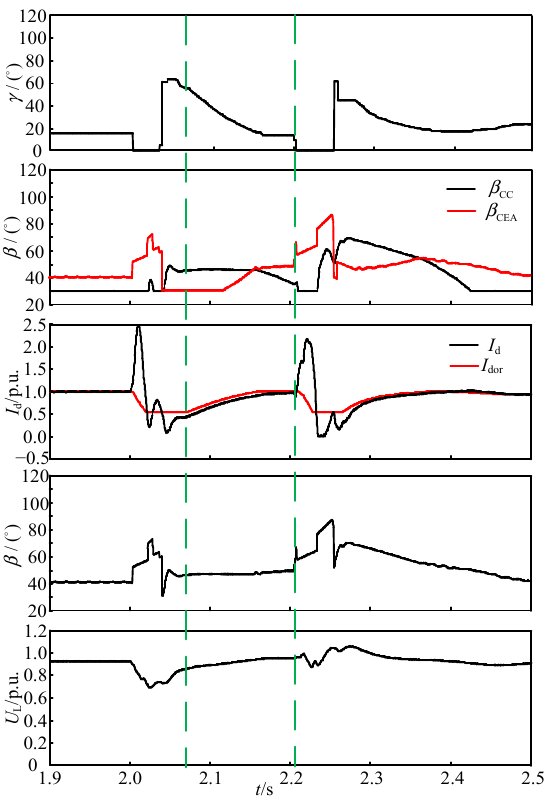
Figure 5. Response waveform of inverter side after three-phase short-circuit grounding fault.